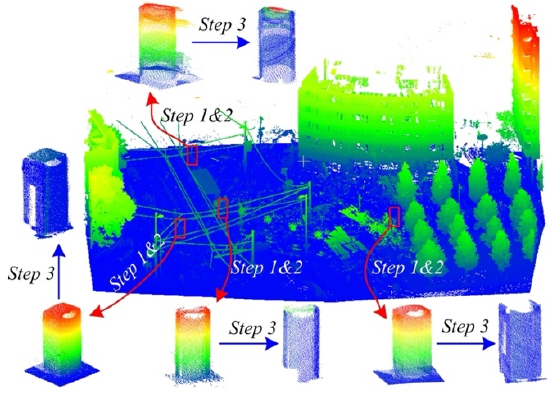
Figure 9 . Recycle bin extraction from MLS data